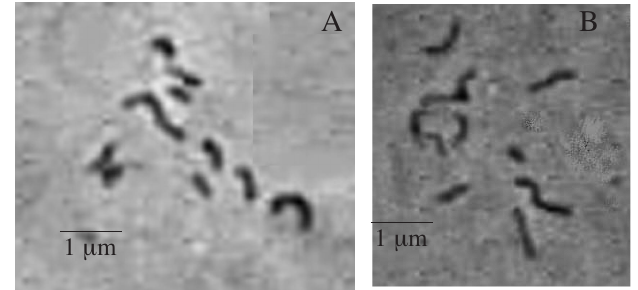
Fig. 2 - Normal metaphase kryotype from embryonic cells of Grape phylloxera, Daktulosphaira vitifoliae Fitch: A) 2n= 10; B) 2n=9 + small chromosome (the arrow).